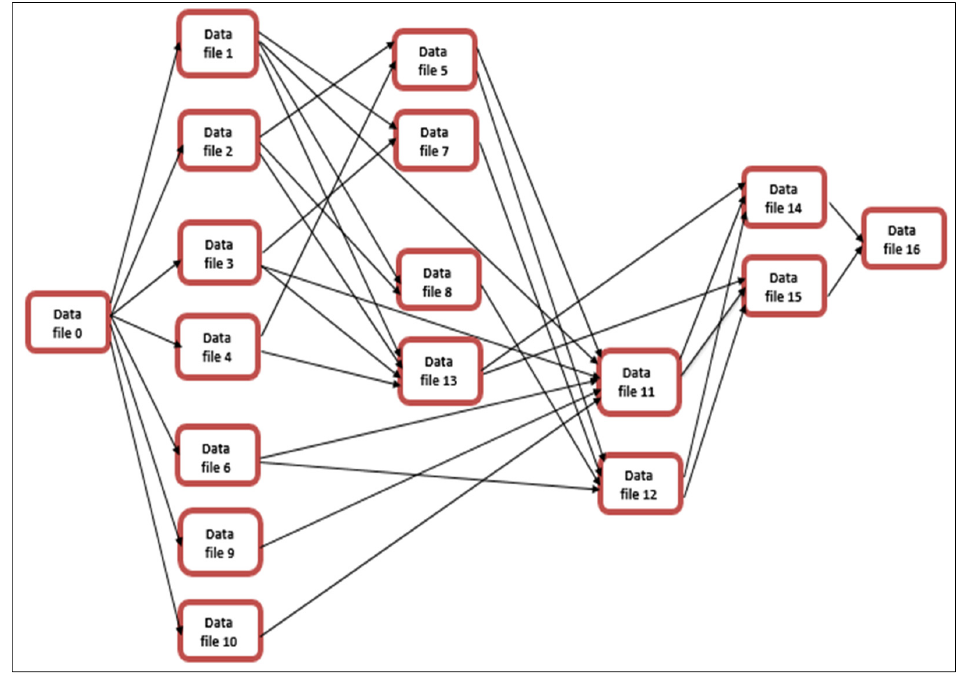
Figure 3. Illustrative example.